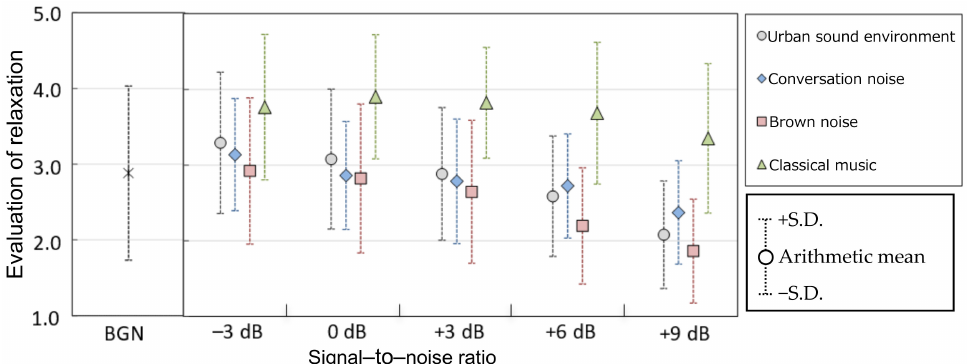
Figure 5. Evaluation of “relaxation” for each sound environment. The plots in this figure represent the arithmetic mean, and the error bars indicate the standard